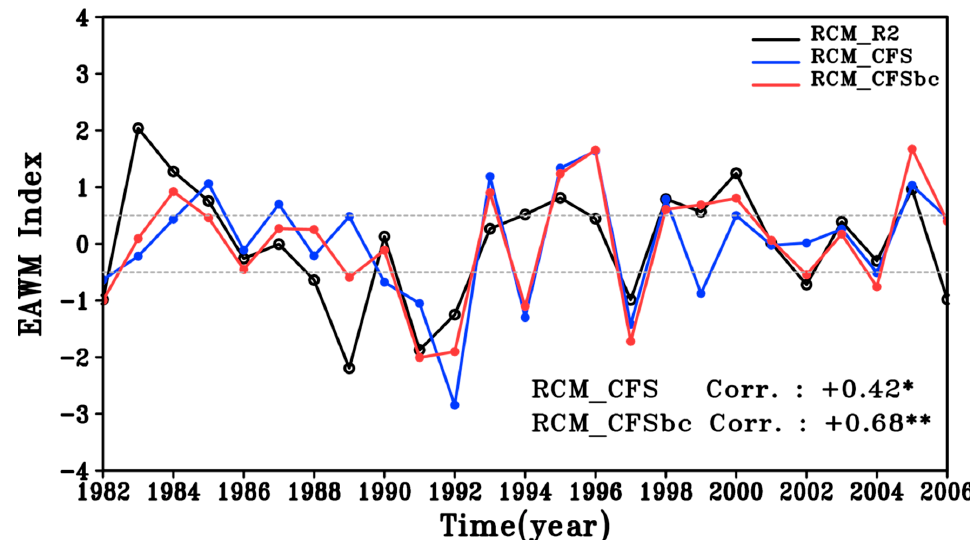
Figure 7. Normalized East Asian winter monsoon (EAWM) index [56] for the RCM_R2 (black), RCM_CFS (blue), and RCM_CFSbc (red) experiment and correlation coefficient between RCM_R2 and RCM_CFS, RCM_R2 and RCM_CFSbc experiment during 1982–2006. Two gray dashed lines indicate ±0.5 σ (* and ** indicate significant at the 95% and 99% confidence levels, respectively).